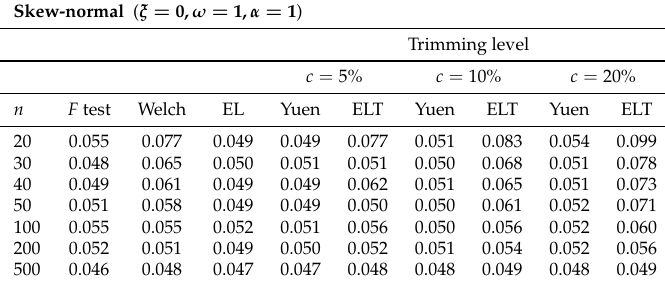
Table 2. Empirical probability of type I error for various tests for the equality of means and trimmed means of three independent skewed distributions with the ratios between variances being